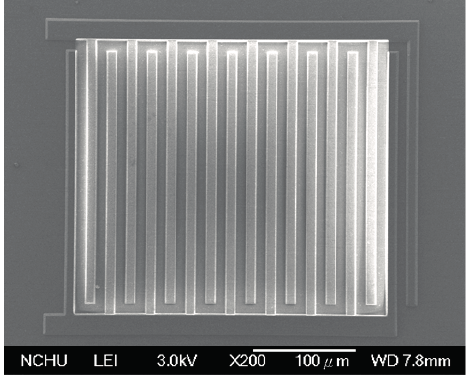
Figure 7. SEM image of the interdigitated electrodes after the wet etching.